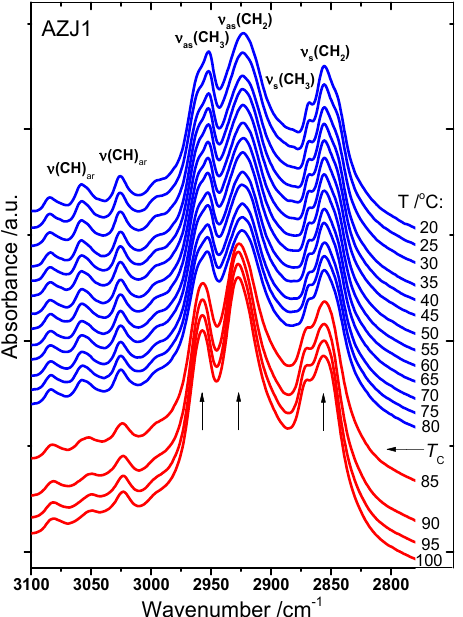
Figure 2. Temperature evolution of the FT-IR spectrum of AZJ1 obtained during heating in the spectral range of 3100–2780 cm − 1 . Ordered and liquid crystal phases are marked blue and red, respectively. The most changed bands upon the transition are marked with vertical arrows.